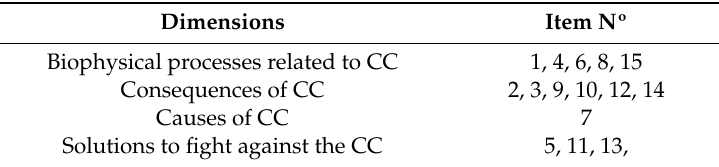
Table 5. Dimensions of the questionnaire and item Nº.